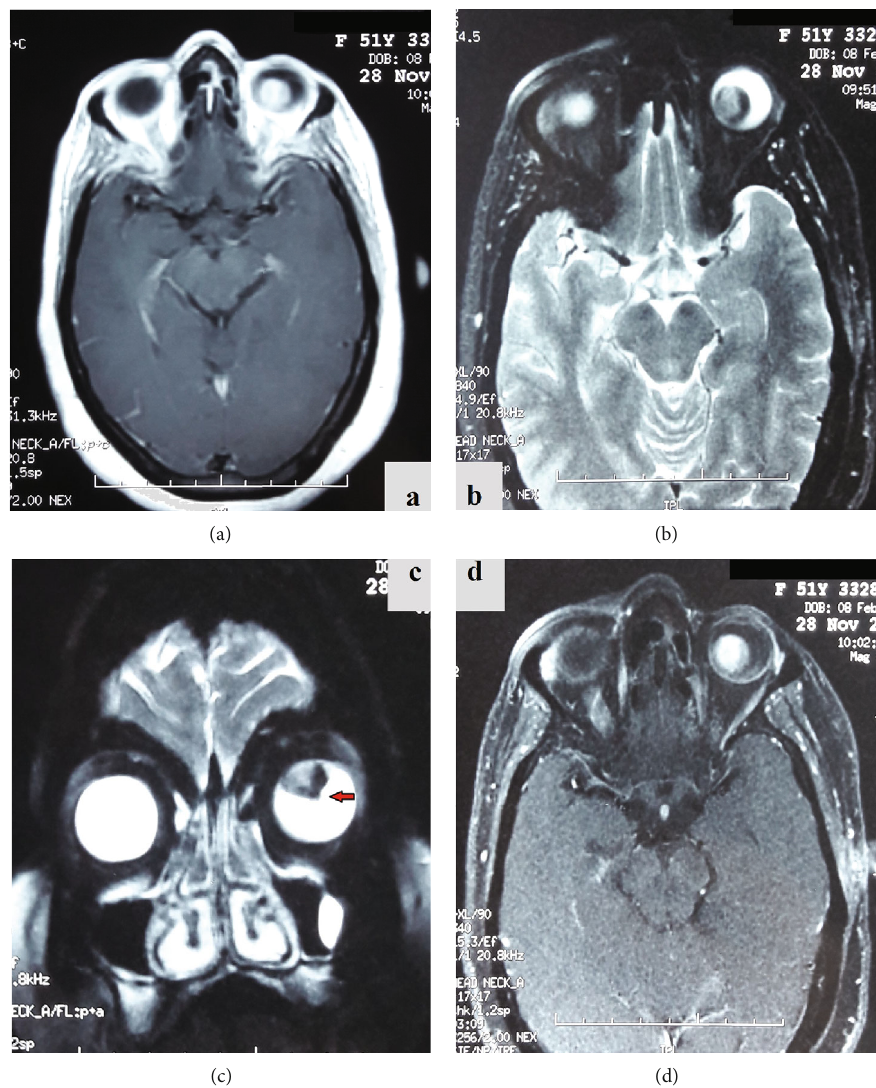
Figure 3: MRI of the orbits: (a) tumor showing high signal intensity on T1-weighted images; (b) heterogeneous appearance and low signal intensity on T2-weighted images; (c) T2-weighted images on a coronal plane: heterogeneous appearance and low intensity with a collar- button extension (arrow); (d) tumor shows enhancement on T1-weighted images with fat suppression, after Gadolinium